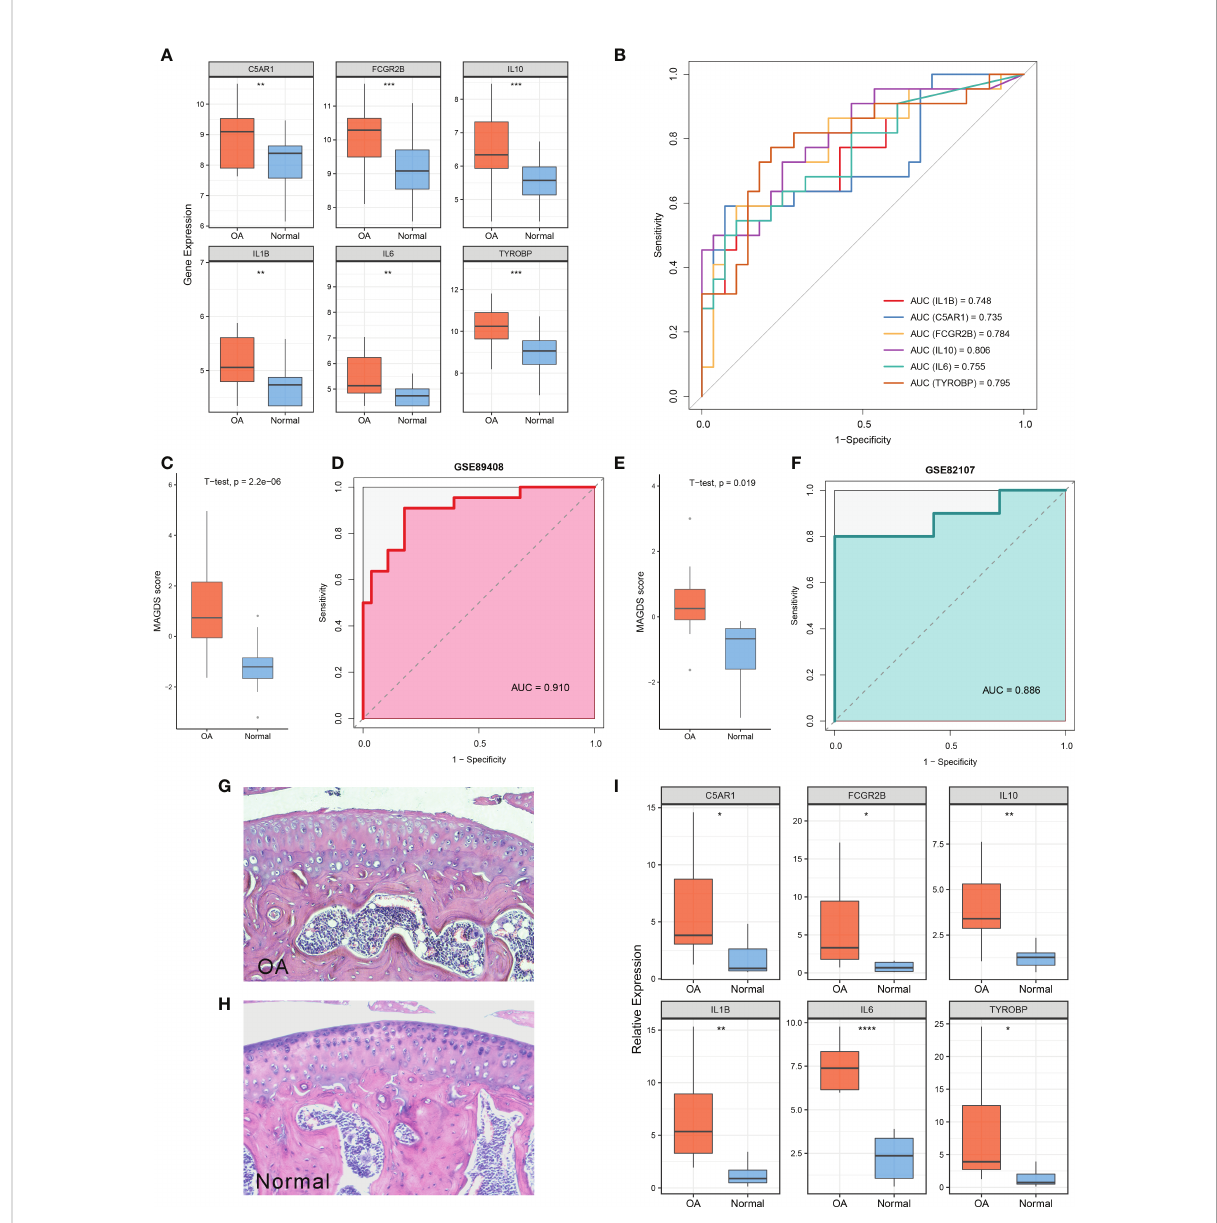
FIGURE 5 Diagnostic and predictive values of MAGDS. (A) Differential expression of the six model MAGs between OA and normal groups. (B) ROC analysis of the six key MAGs for OA diagnosis. (C) The distribution of MAGDS scores between OAs and controls in GSE89408. (D) ROC analysis of MAGDS for OA diagnosis in GSE89408. (E) The distribution of MAGDS scores between OAs and controls in GSE82107. (F) ROC analysis of MAGDS for OA diagnosis in GSE82107. (G, H) . HE staining of paraf fi n sections of knee joints from OA (G) and normal mice (H) . Magni fi cation, ×100. (I) Relative expression of the six model MAGs between OA and normal mice. Statistic tests: two-sided t-test. ns P > 0.05, *P < 0.05, **P < 0.01, ***P < 0.001, and ****P <